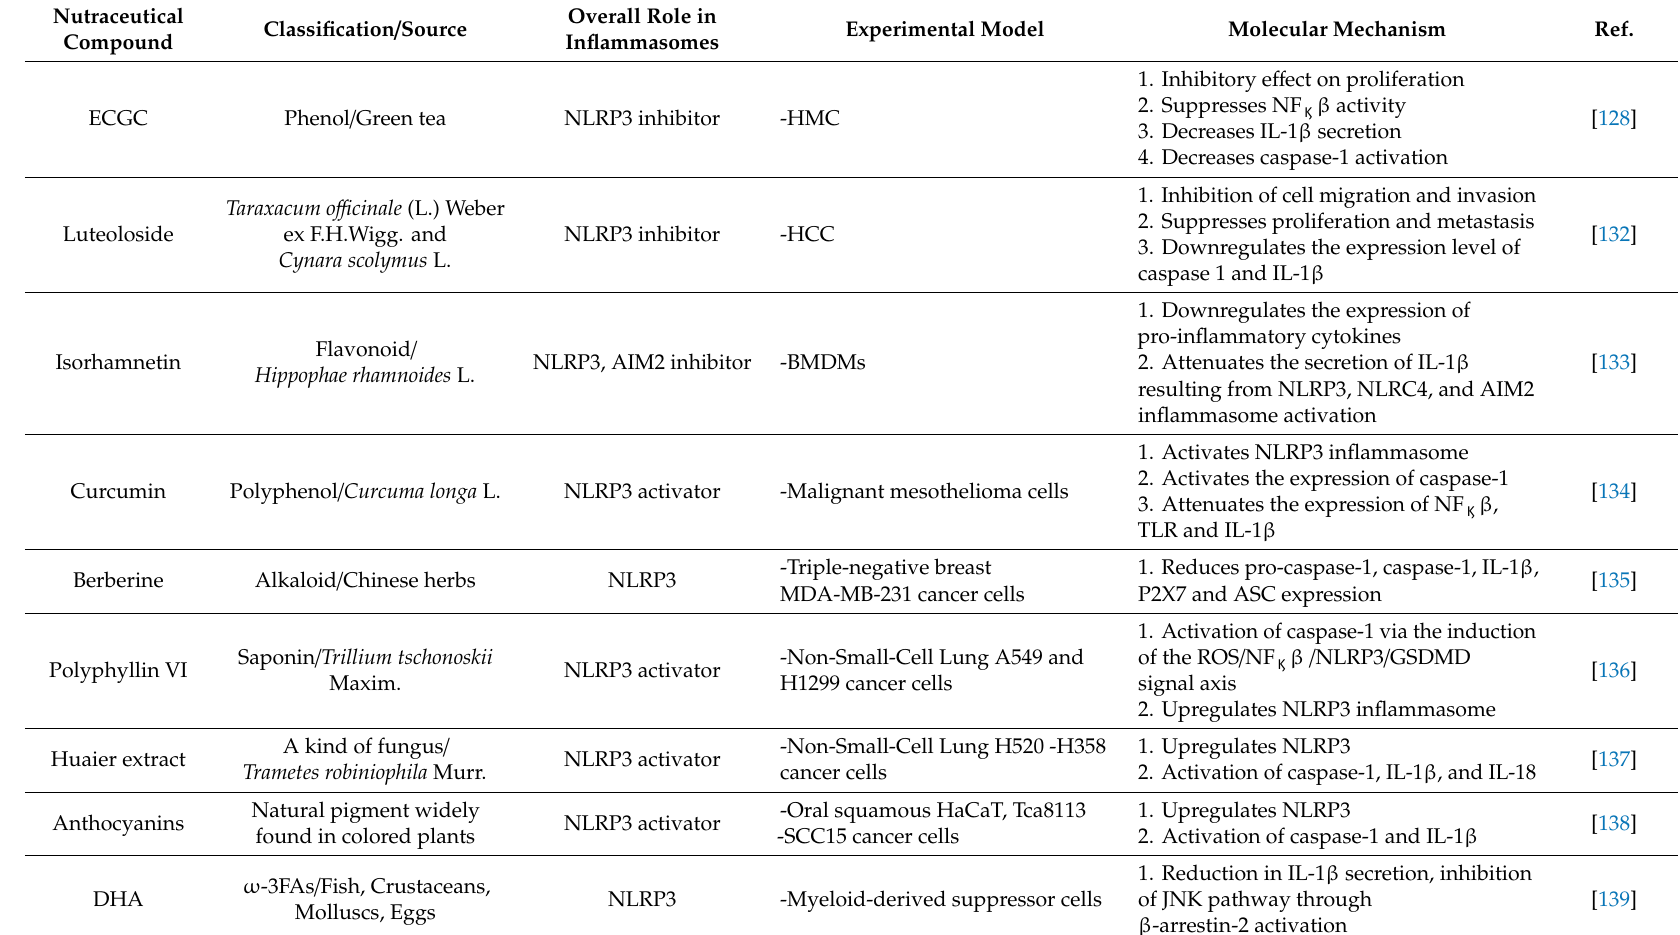
Table 4. List of Nutraceutical Compounds targeting Inflammasomes in